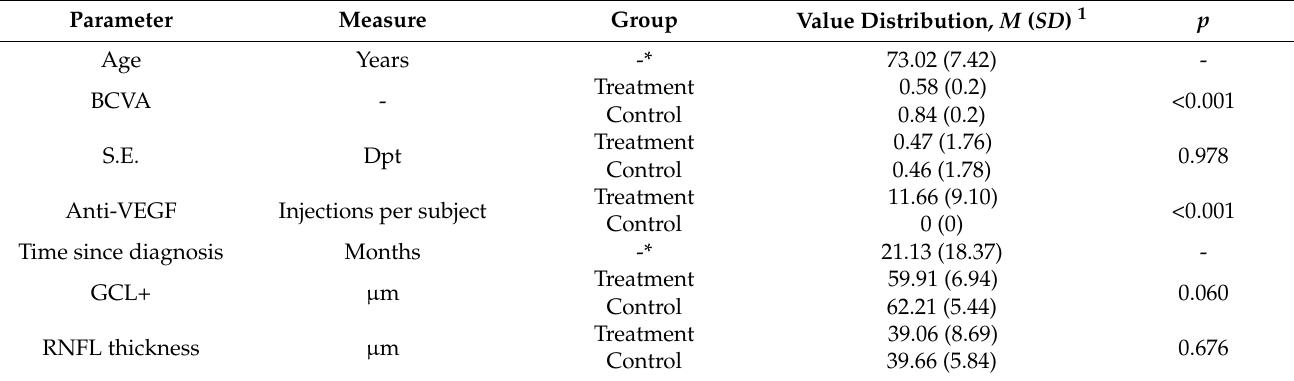
Table 5. Characteristics of the continuous variables of the sample, N = 106, n =